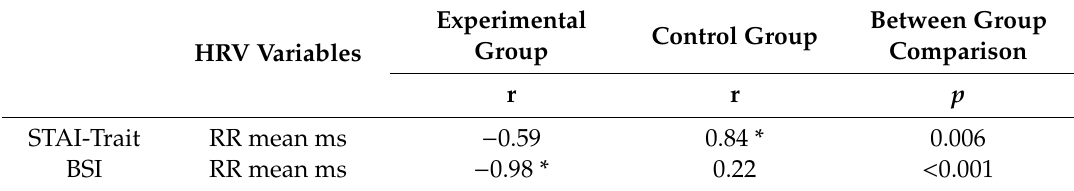
Table1. Partialcorrelationcoe ffi cients(adjustedforage)betweentheR-Rmeanmsandthepsychological distress measures, within and between Table 1. Partial correlation coefficients (adjusted for age) between the R-R mean ms and the psychological distress measures, within and between groups.